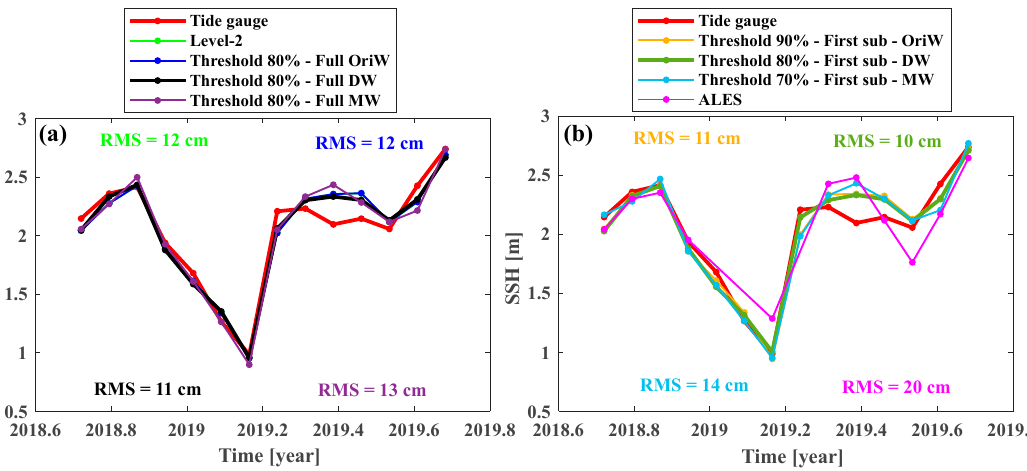
Figure 15. Water level time series of the Persian Gulf pass 25 based on our waveform retracking scenarios and ALES dataset in front of tide gauges, ( a ): full-waveform and ( b ): sub-waveform.